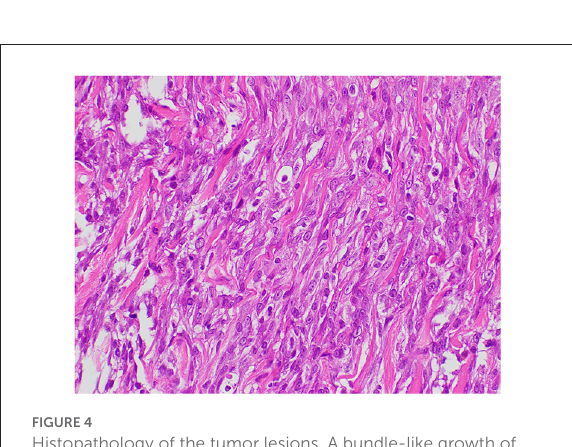
FIGURE4 Histopathology of the tumor lesions. A bundle-like growth of spindle-shaped mesenchymal tumor cells was observed between the myofibril and the collagen bundles. The tumor cells were moderately irregular in size and had eosinophilically stained cytoplasm. The tumor cells were highly atypical, and mitotic figures were rare. No intravascular invasion of the tumor in the search area was